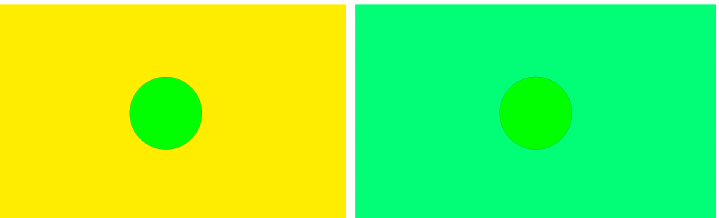
Figure 1. An example background change: in spite of the fact that the inner disks in the center of the two images provide exactly the same physical color stimulus, our perception of them is different because of the so-called chromatic induction phenomenon due to the background